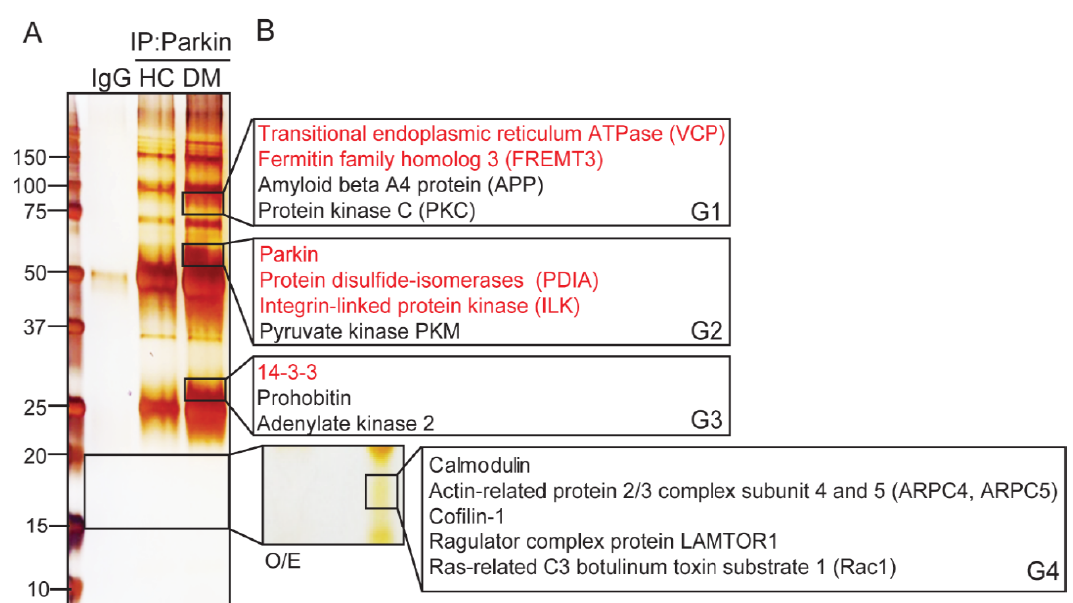
Figure 2. Identification of Parkin-interacting proteins in human DM platelets. ( A ) Immunoprecipitation of Parkin-interacting proteins in human DM platelets visualized by silver staining. We isolated 10 enriched bands from DM and compared it with HC for LC-MS/MS analysis. ( B ) Potential interacting proteins were analyzed by LC-MS/MS and using Mascot analysis.